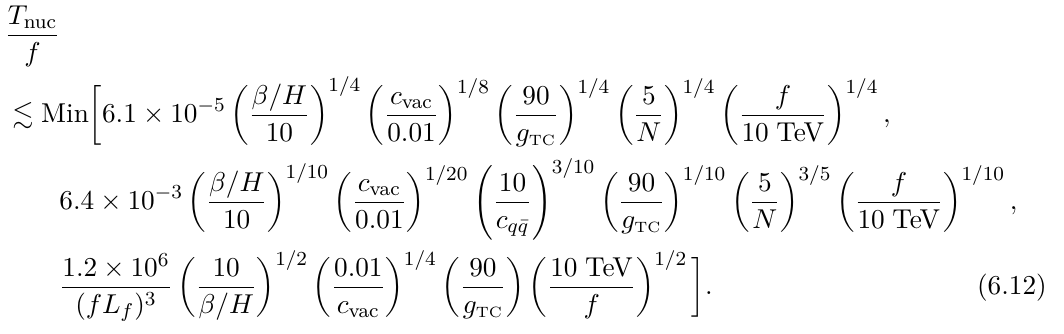
and T , vac start